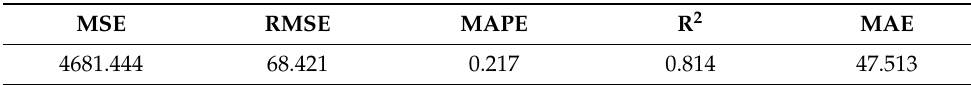
Table 1. Validation Metrics of the ARIMA